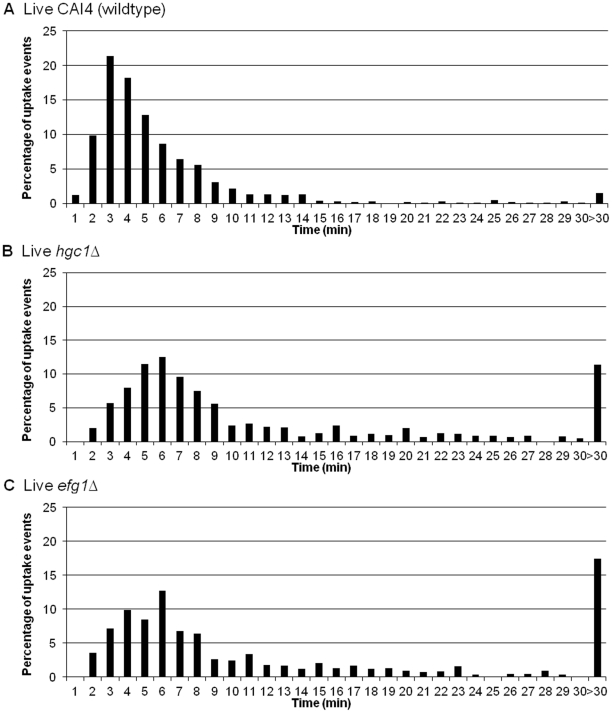
Macrophage engulfment of wildtype and yeast-locked morphogenetic mutant strains of C. albicans.
Figures 5A, B and C show the time taken for J774.1 macrophages to ingest live wildtype (n = 6), hgc1Δ(n = 6) and efg1Δ (n = 3) following initial cell-cell contact plotted versus the percentage of uptake events. The average time taken for engulfment of the hgc1Δ (Figure 5B) and efg1Δ (Figure 5C) mutant strains was significantly greater than for the wildtype control (Figure 5A).